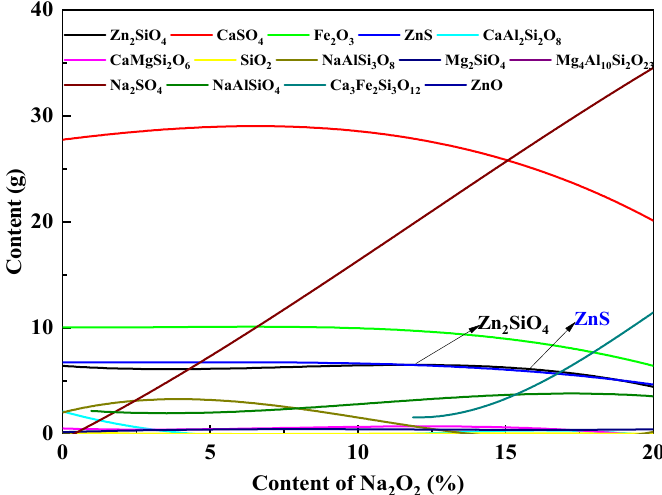
Figure 5. The effects of the Na 2 O 2 doping concentration on the equilibrium composition of produc- tions.